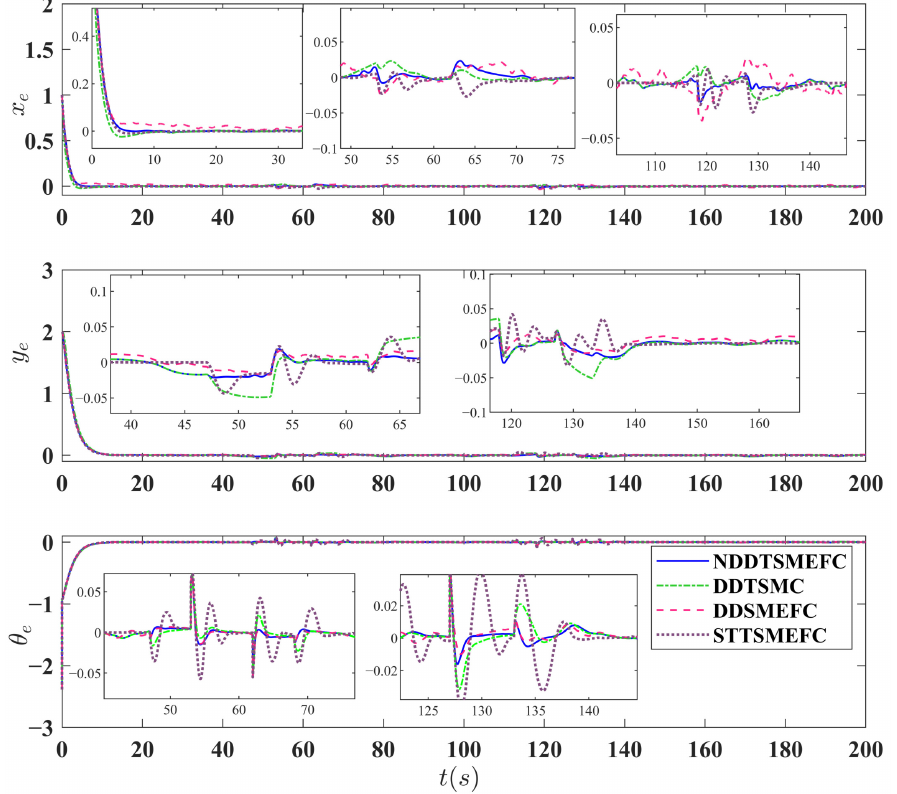
Figure 7. Schematic diagram of UTROV position error.